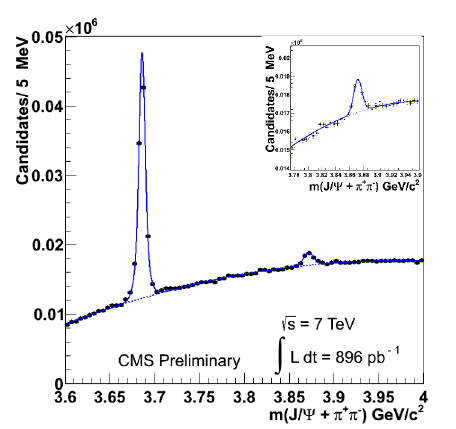
Fig. 4. J /ψπ + π − invariant mass spectrum in the region p T ( X ) > 8 GeV and | y ( X ) | < 2 . 2. The insert shows the mass region around the X